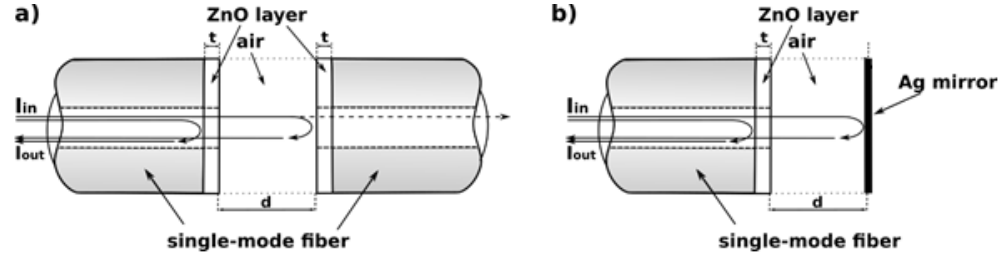
Figure 1. The construction of the fiber-optic Fabry-Pérot interferometer in the reflective mode: ( a ) all-fiber (with both interferometer mirrors made of ZnO layer); ( b ) with one of the interferometer mirrors in the form of a silver plate, where: d—the cavity length, t—thickness of the ZnO layer.